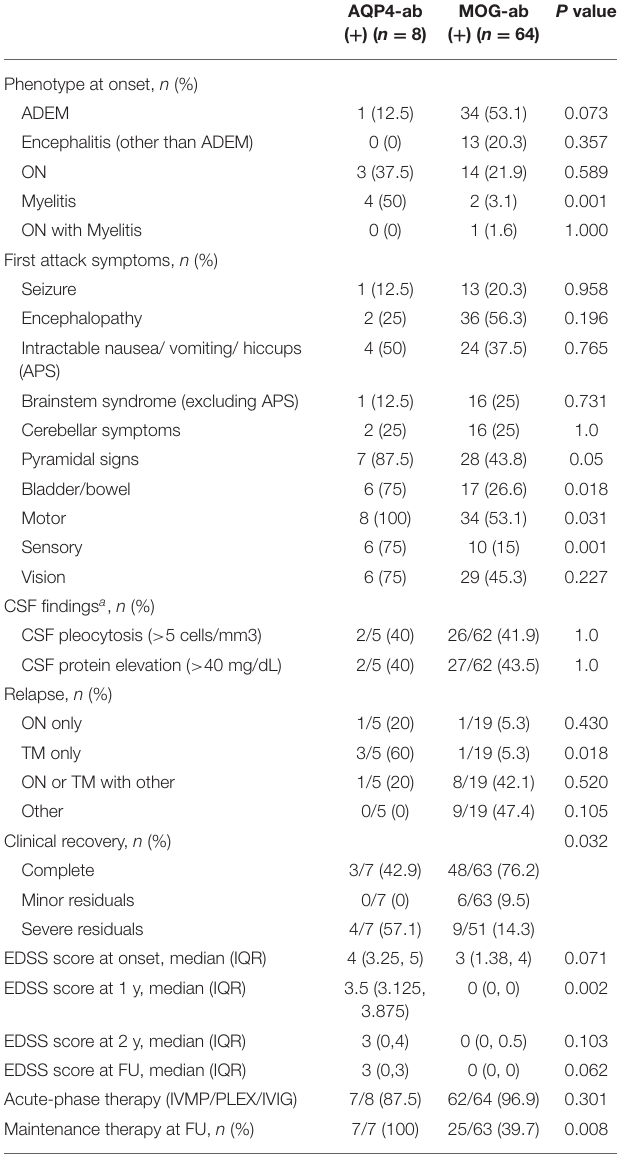
TABLE 2 | Comparison of clinical characteristics in AQP4-ab-positive and MOG-ab-positive children.